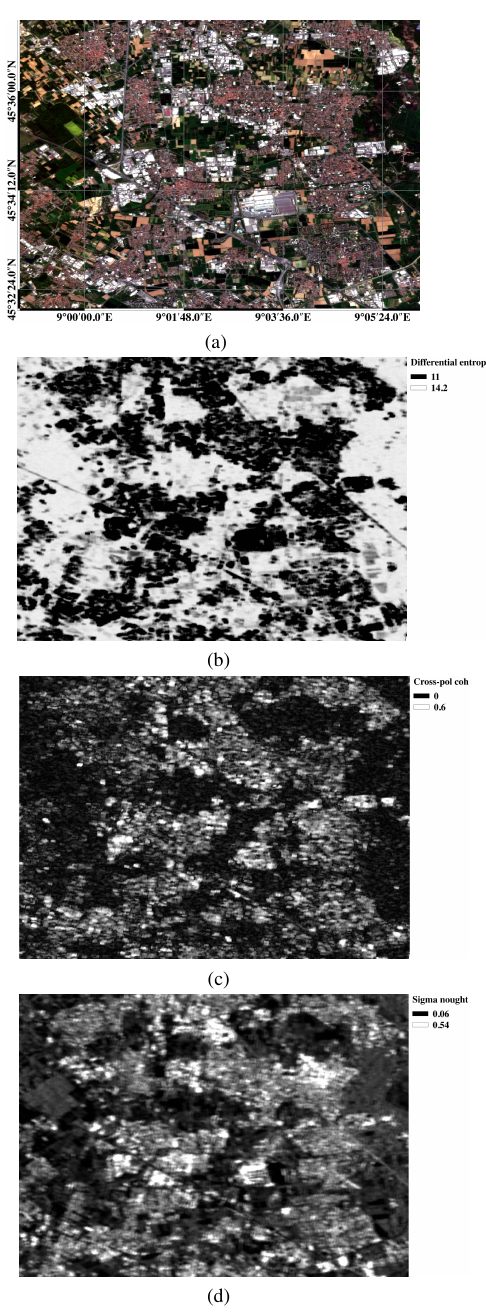
Figure 1: SAR features, Lainate (Italy). Estimation is performed over a rectangular window of 25x5, with a descending stack of 10 images. (a) Sentinel-2 RGB Image (b) Differential entropy (c) Polarimetric coherence (d) Calibrated